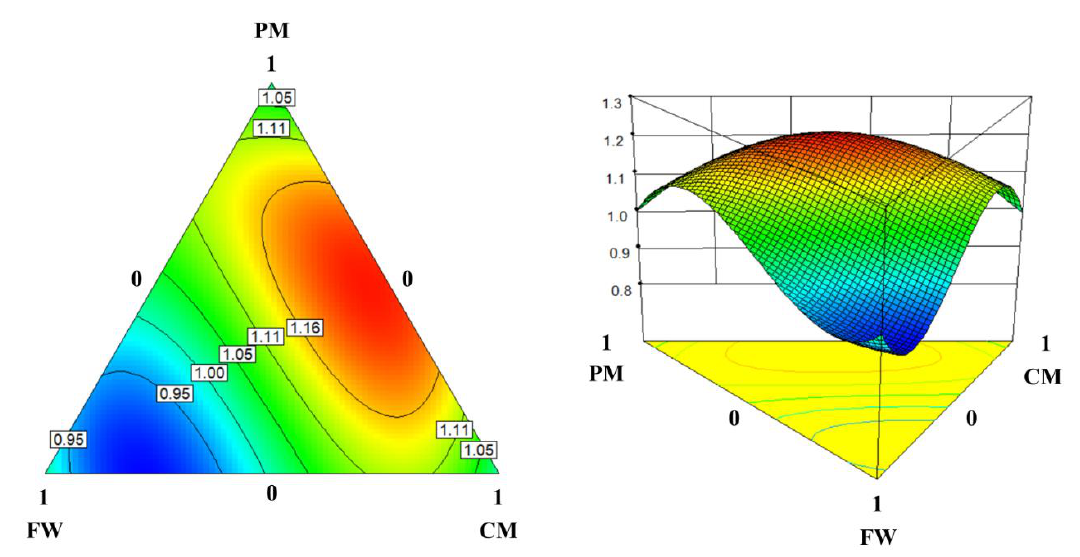
Figure 4. Two- and three-dimensional response surface plots illustrating the effect of the substrate mixing ratio on the 30-day synergy index. Contour colors represent the levels of model response: blue for low and red for high responses.